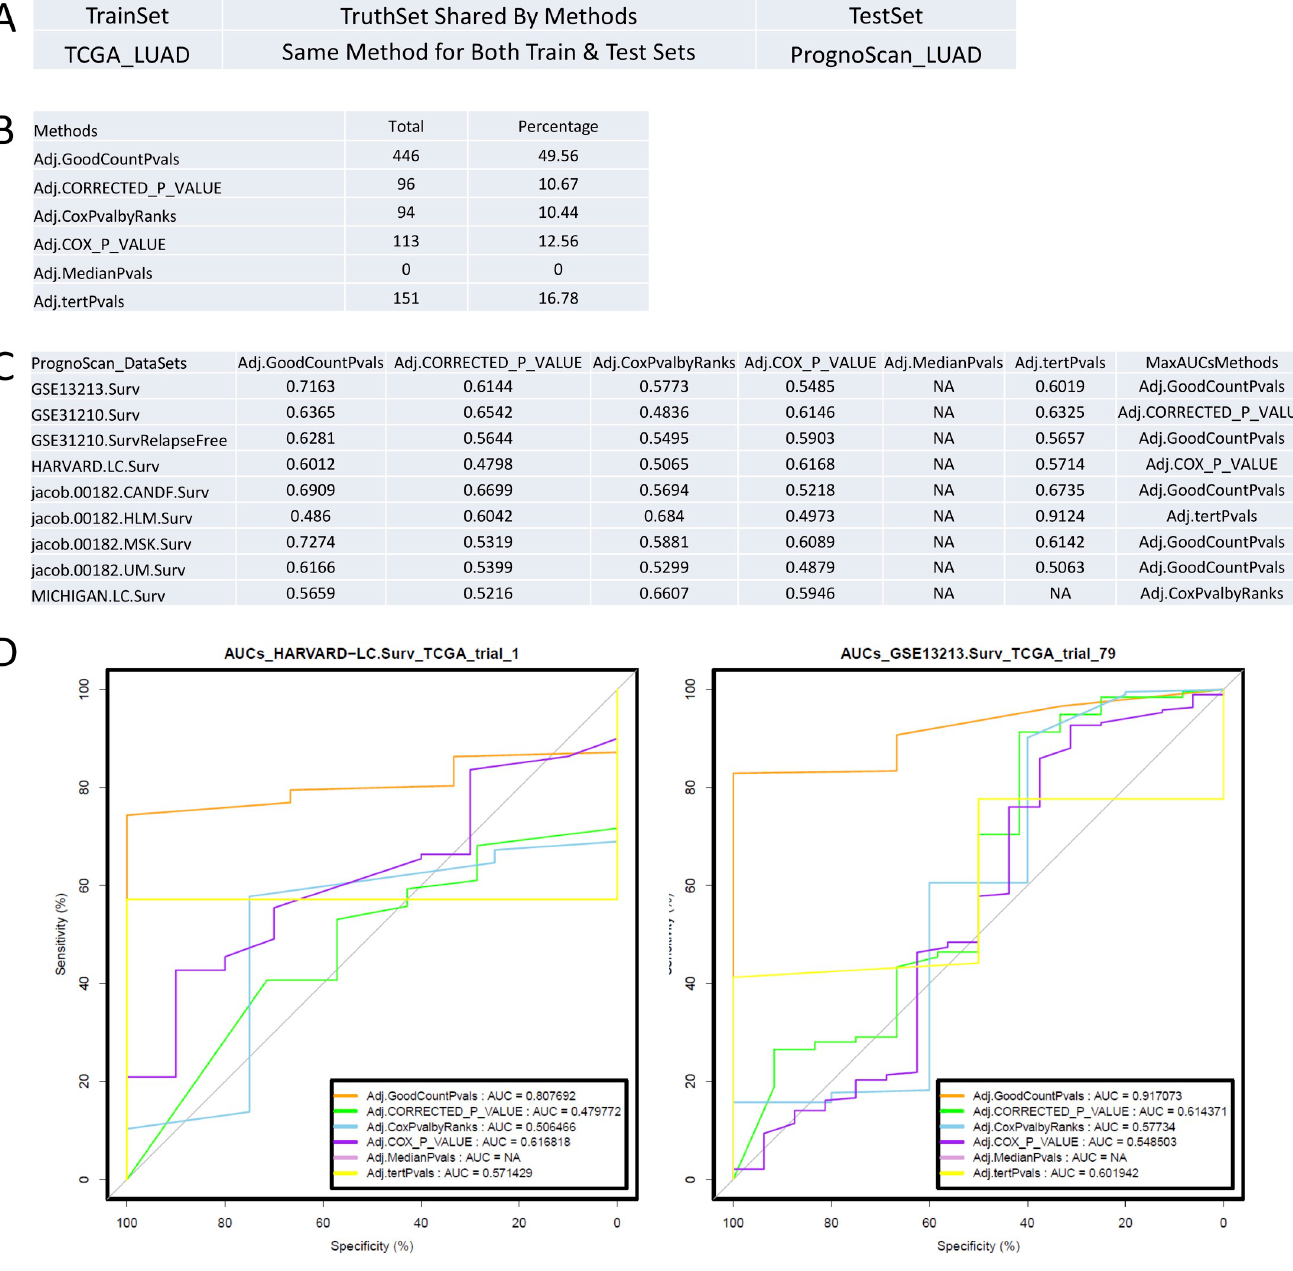
Fig 5. Performance comparison by ROC analysis with the same set of Training Set and Testing Set for the same method. (A). ROC analysis comparing all listed methods, each of which has been applied to the same set of Training Set and Testing Set for the same method. The settings table shows which datasets were used for the Training Set and Testing Set. The same method has been applied for the same set of TCGA LUAD data as Training Set and PrognoScan LUAD data as Testing Set. (B). Performance comparison table listing numbers of times/trials that a method has the largest AUCs of the ROC curves compared to other methods for the same set of Training Set and Testing Set datasets are shown in panel A. Column “Total” summarizes the total counts of all of the best trials of same Training Set and Testing Set datasets for each method listed in column Methods. Column “Percentage” lists the proportions of those counts. All truth lists derived from the Training Set and the result lists derived from Testing Set are at adjusted p-value < = 0.05 for each method. The details of each trial are shown in Table E in S1 File . (C). Average AUCs of ROC analysis for each method in each subset of total trials of data defined by 100 trials of TCGA data combined with one of the indicated PrognoScan datasets in column “PrognoScan_Datasets” (also see Materials and methods section for details). The last column”MaxAUCsMethods” shows the methods with the maximal AUC for each row. (D). Examples of ROC plots showing that the AUCs of the GradientScanSurv method are the largest in these trials. AUC = NA is due to the fact that the MedianPvals method has no positive calls in Training datasets at adjusted p-value < =